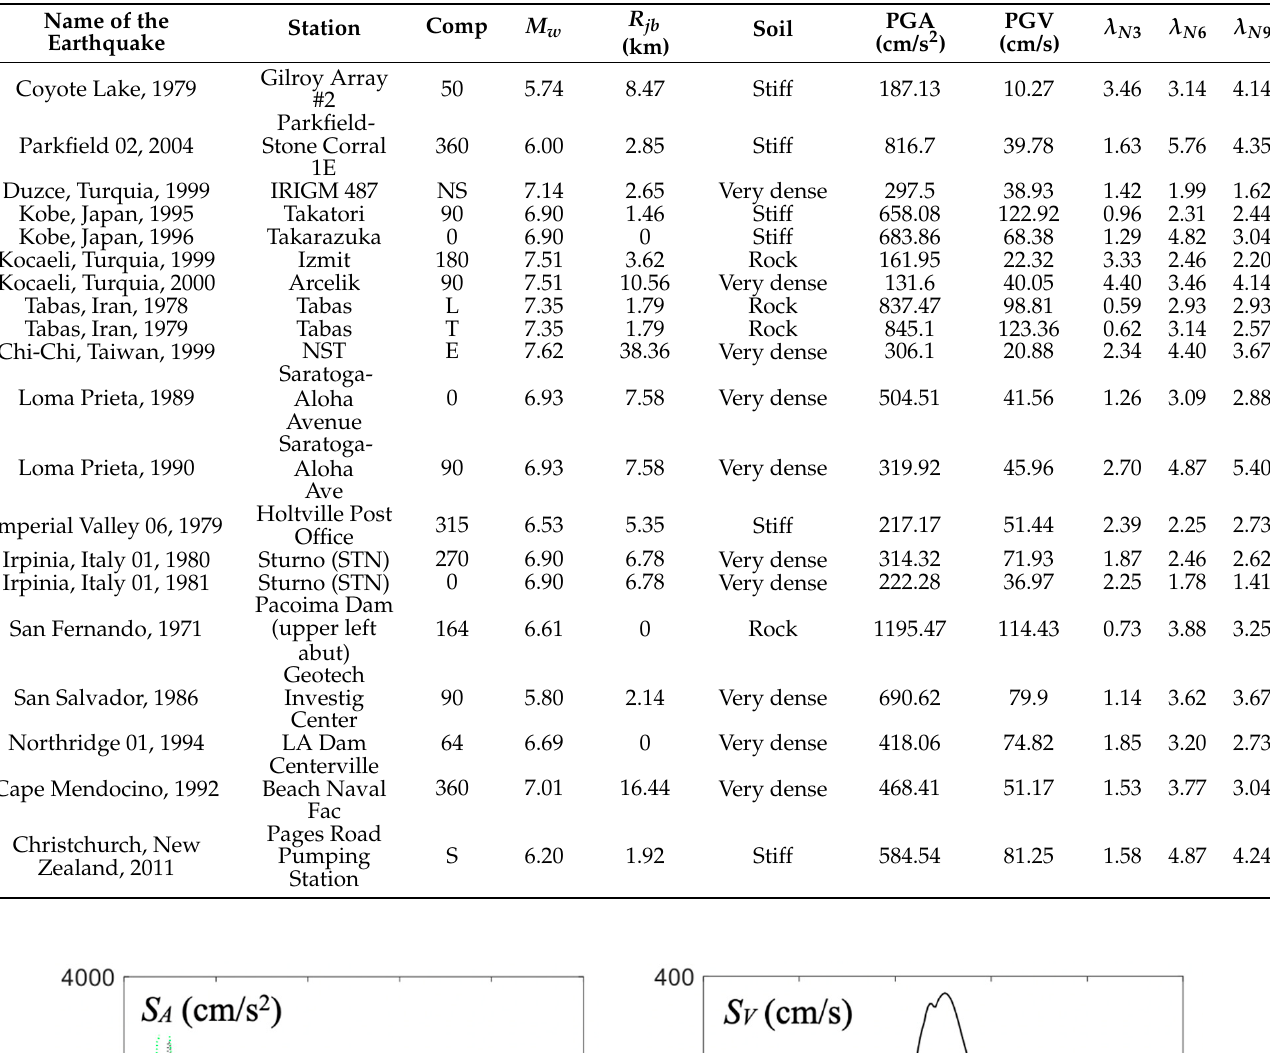
Table 4. Earthquake data of selected pulse-like ground motion records.